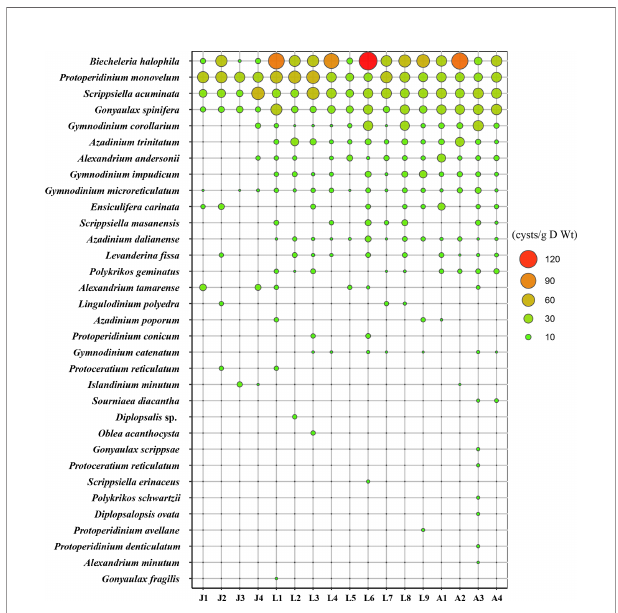
FIGURE 6 | Distribution of dinocysts according to their average